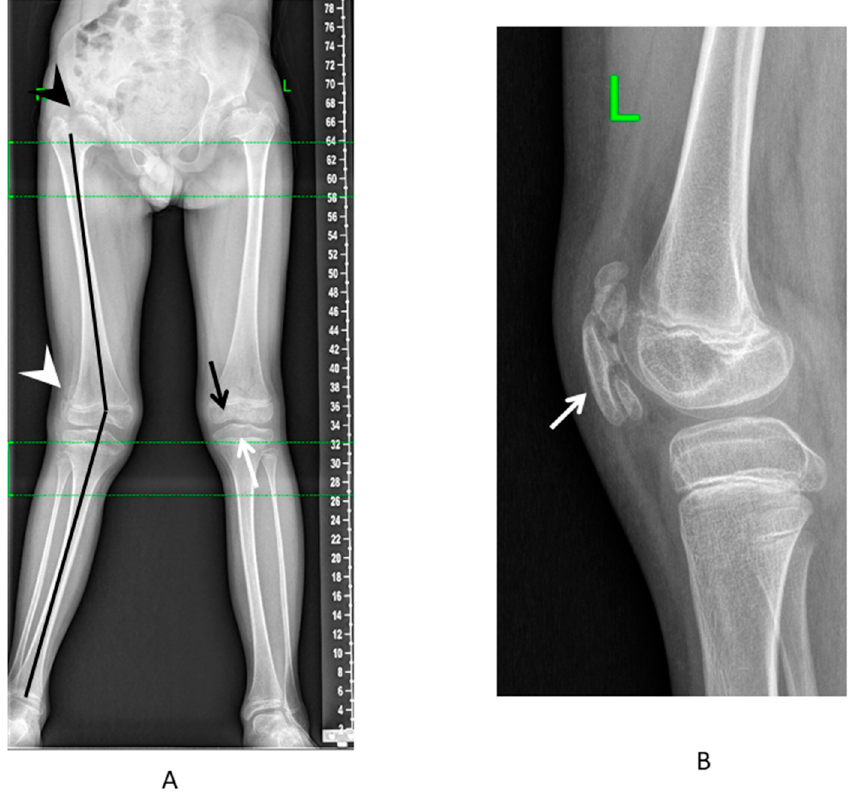
Figure 3. Typical lower limb involvement in patients with MED type 4. ( A ) Standing anteroposterior radiograph of the lower limbs: valgus deformity of the axis (black line), mushroom-shaped deformity of the femoral head (black arrowhead), lateral patellar subluxation (white arrowhead), flattening of the distal femoral (black arrow), and proximal tibial (white arrow) epiphyses. ( B ) Lateral radiograph of the knee—multilayer patella (white